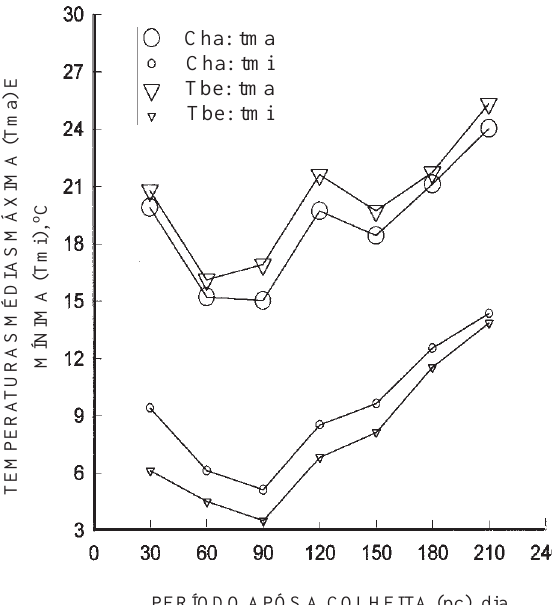
Figura 6. Temperaturas médias máximas (tma), e mínimas (tmi), mensais, ocorridas em Lages (Cha), e Lebon Régis (Tbe), no período de 225 dias após a colheita manual da cultura (pc), de maio a dezembro de